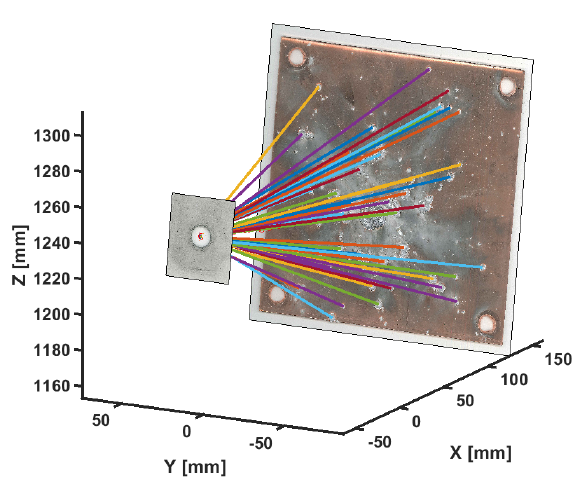
Figure 5. The target, witness plate, and shot axis in world coordinates. Craters in the witness plate and the location of the target hole are used to estimate the 3D trajectories of each fragment. Shown here are the best fitting trajectories for each